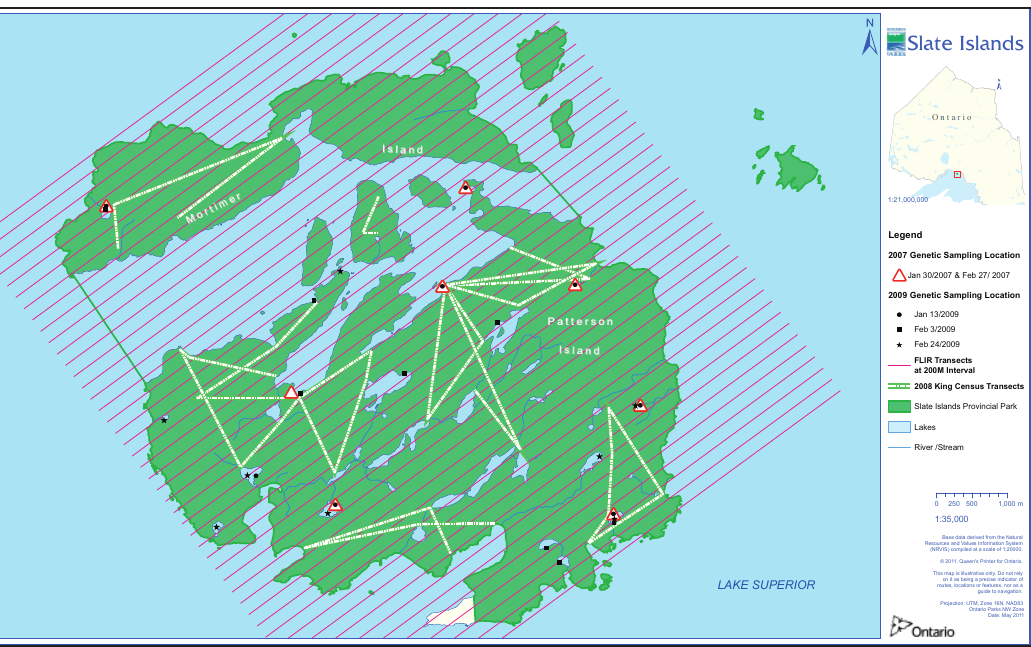
Fig. 2. Locations of faecal pellet collections, ground and FLIR transects surveyed to obtain population estimates of cari- bou on the Slate Islands,